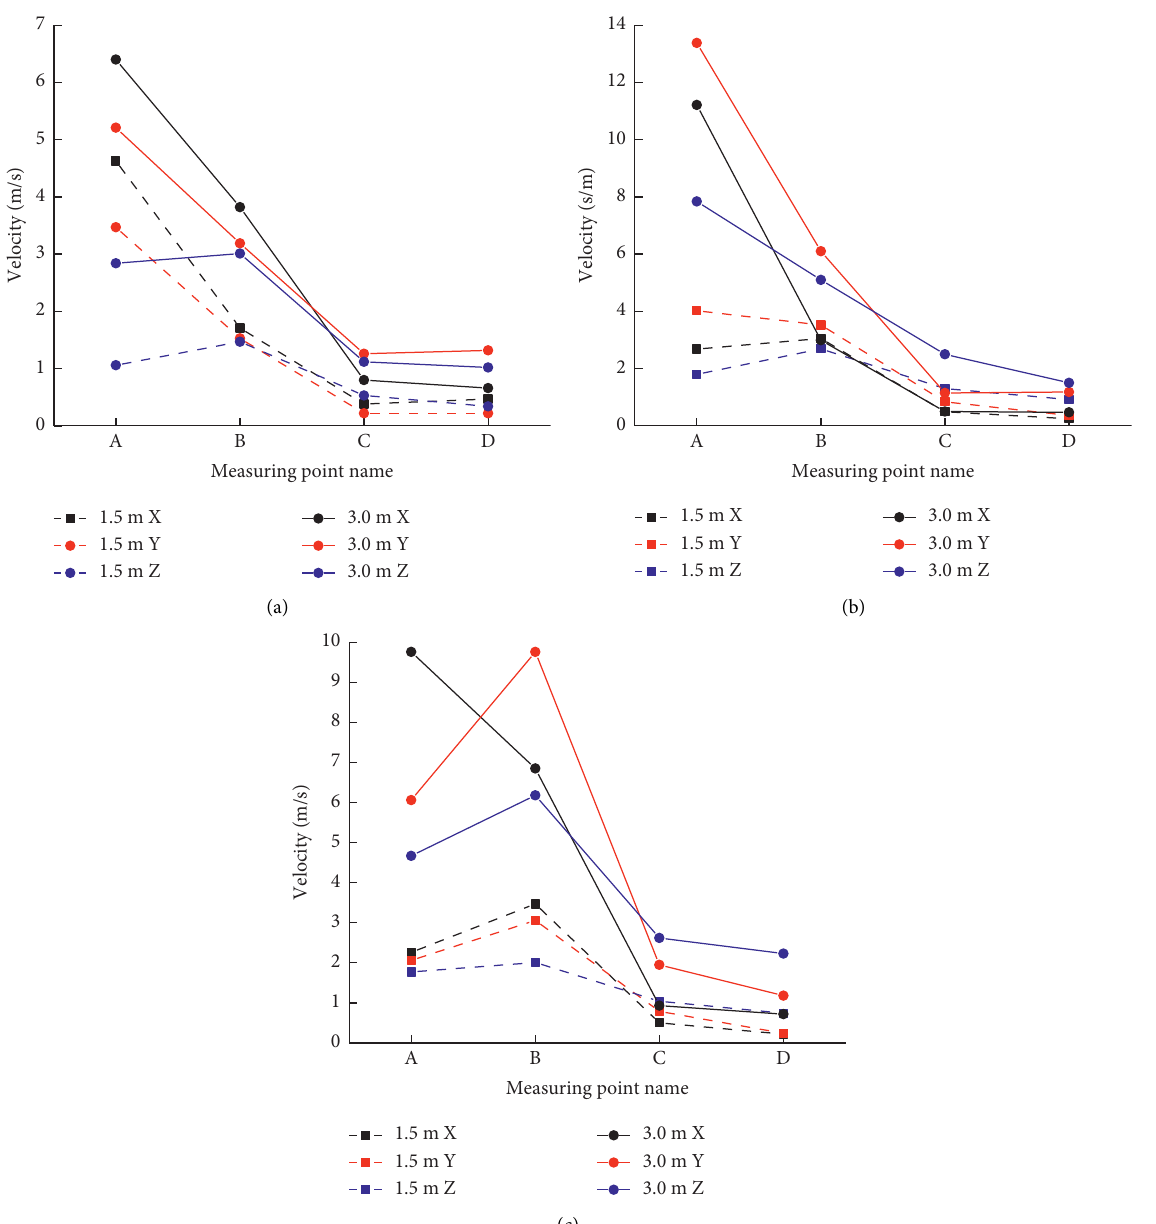
Figure 9: Comparison of 3D vibration velocities of typical blasting segments with different footage conditions at the monitoring points A, B, C, and D positioned on the arch of the completed tunnel at a position commensurate with the corresponding blasting face. (a) Cutting segment, (b) floor segment, and (c) contour